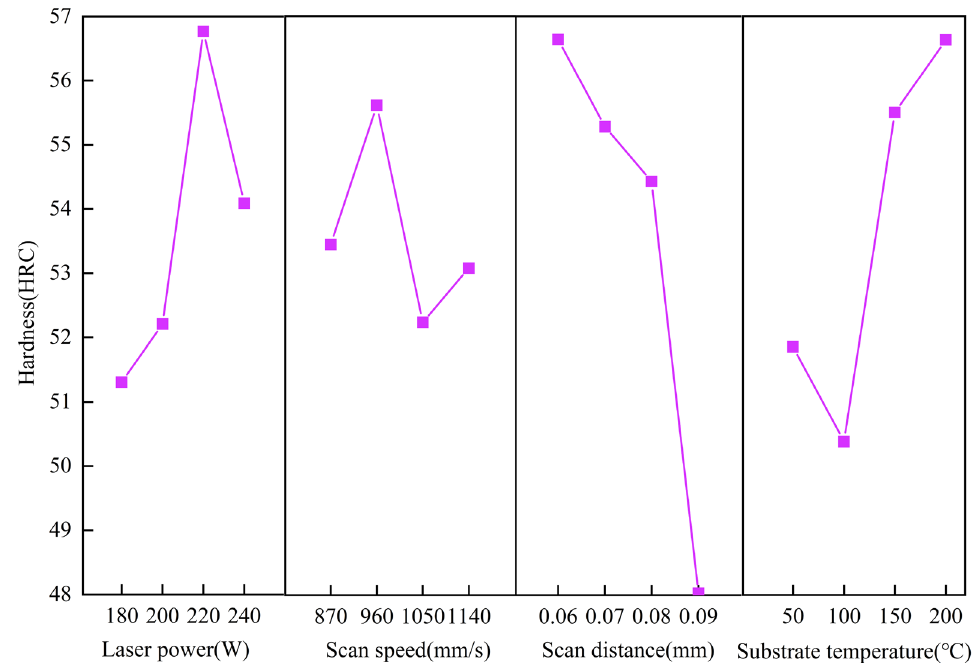
Figure 5 Taguchi experimental curve on